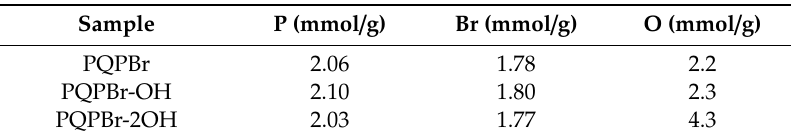
Table 2. The elemental contents of the prepared samples.